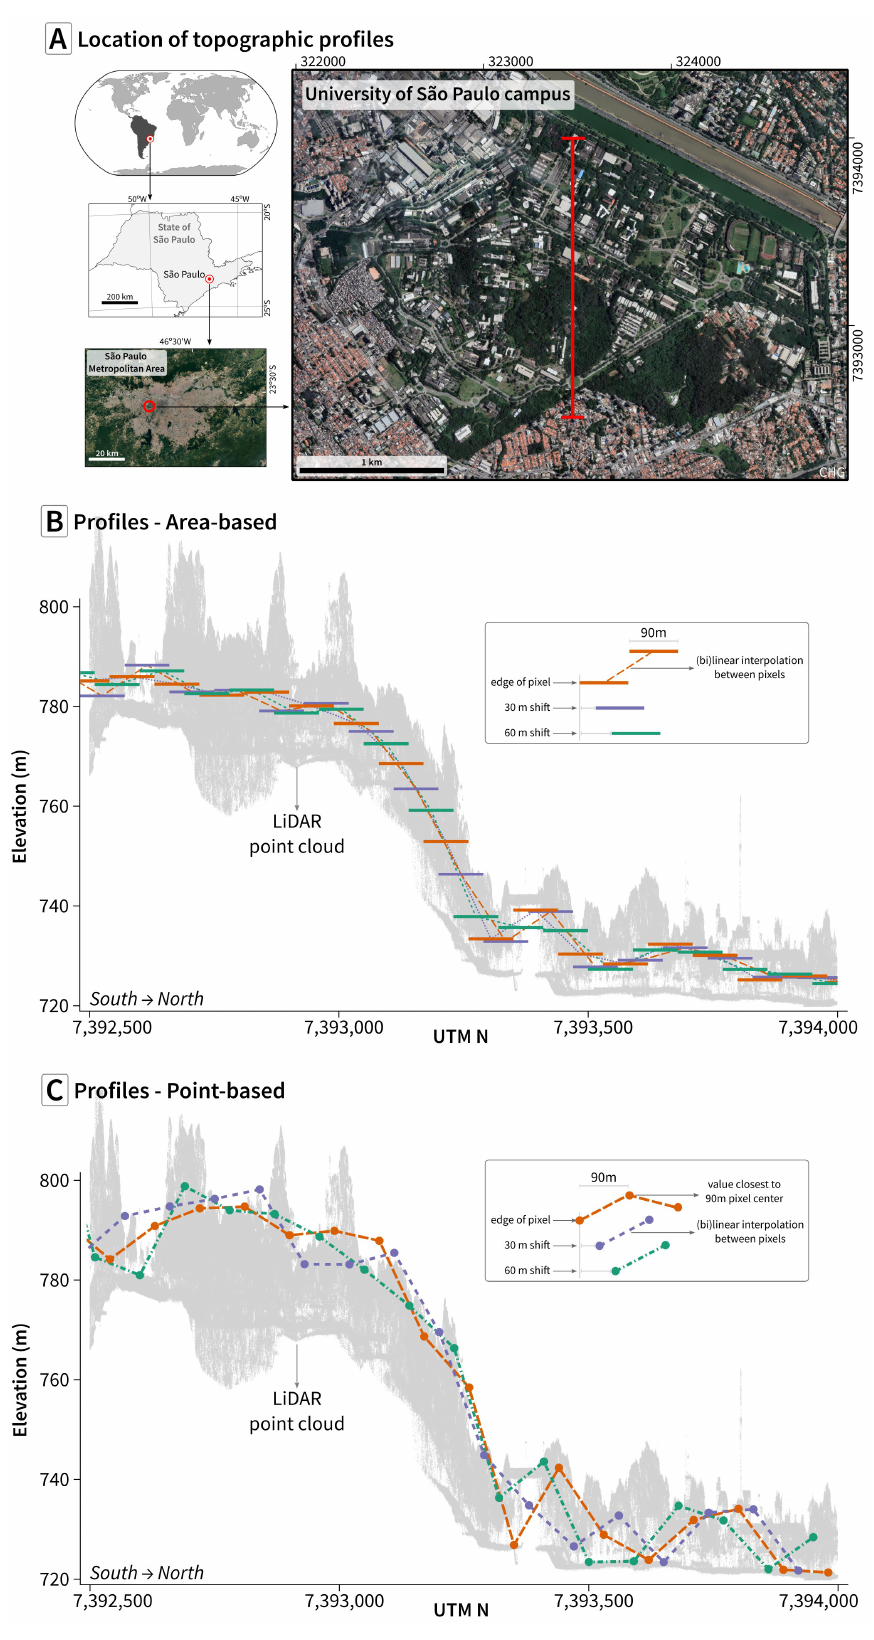
Figure 5. Lidar point cloud from a university campus in Brazil. ( A ) Location of topographic profiles. ( B ) Area-based, which depicts the average elevation in the pixel. ( C ) Point-based DEM representation, which uses a single point elevation for the pixel (here the closest value to the 90 m pixel